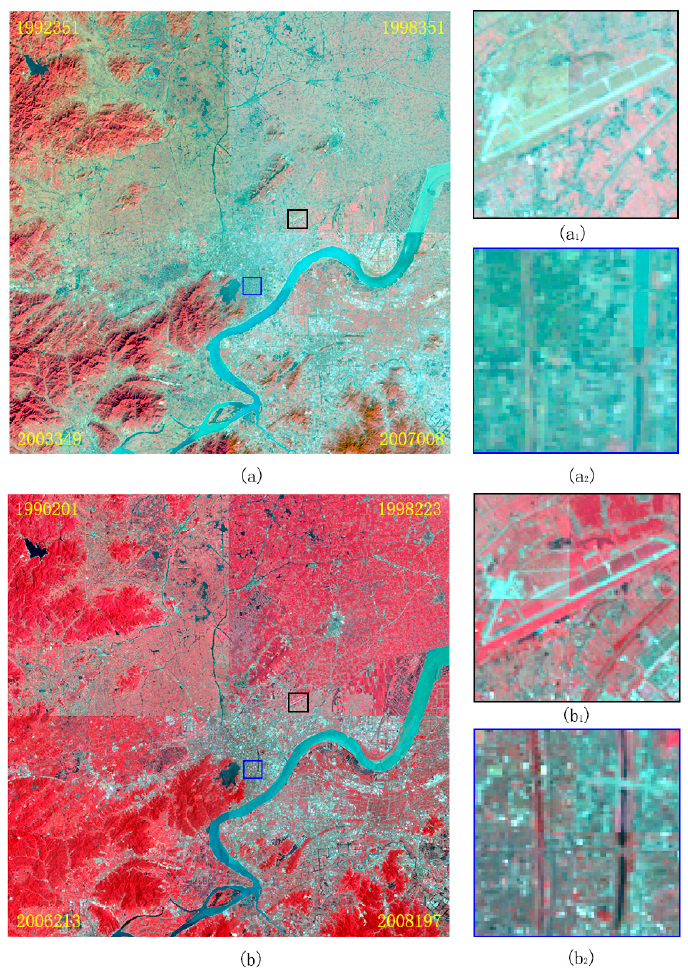
Figure 7. Resultant images of radiometric normalization. Panels ( a , b ) are the mosaicked results by four images corresponding to Figure 2. Panels ( a1 , a2 , b1 , b2 ) are two local areas that show very similar radiometric features, indicating the effectiveness of our method. Note that the color difference between vegetative land cover indicates that our method can maintain the radiometric